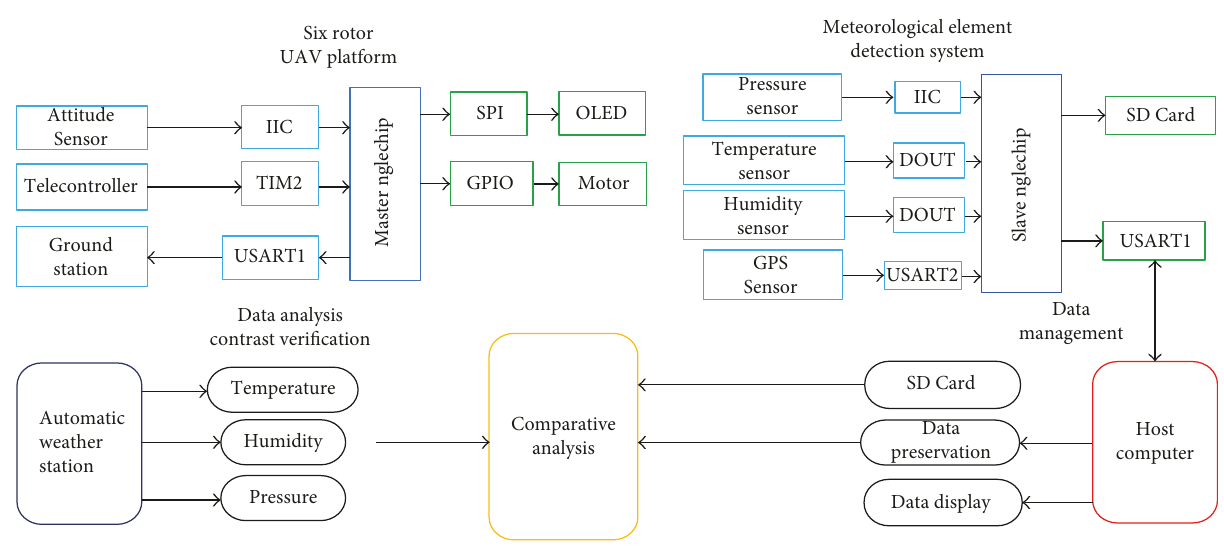
Figure 1: System